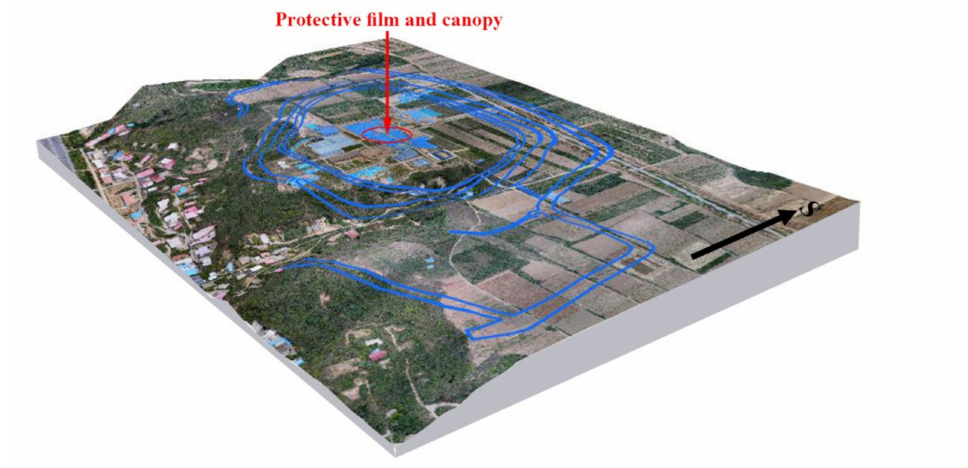
Figure 11. Modern 3D model of the core area of the SHS